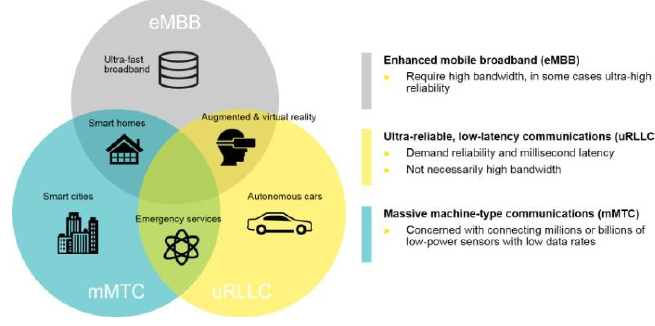
Fig. 2 will show the features of eMBB, mMTC, and URLLC.